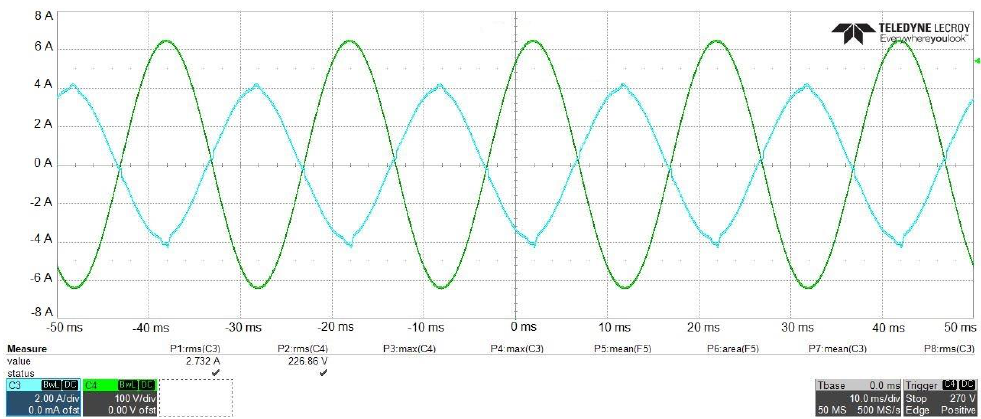
Figure 20. Mains voltage (C4, green) and current (C3, blue) at 75 kHz.